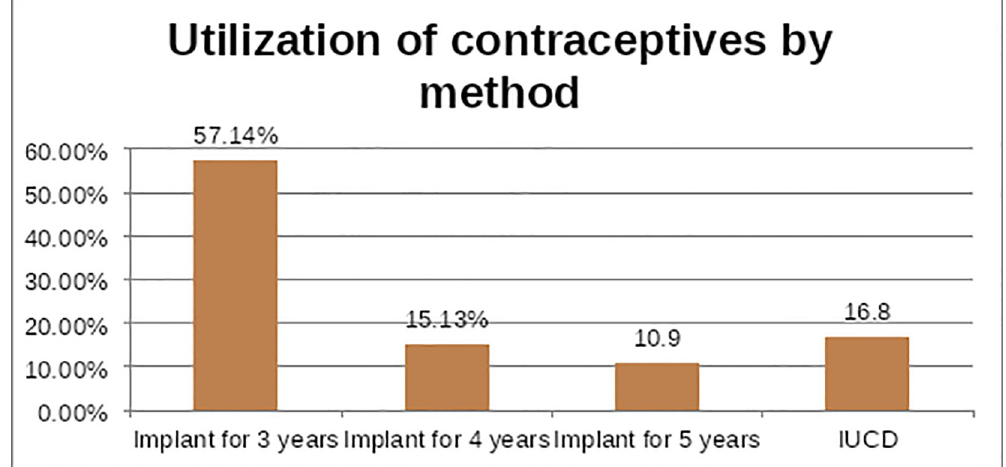
Fig 2. The utilization contraceptives by method in South wollo zone hospitals,